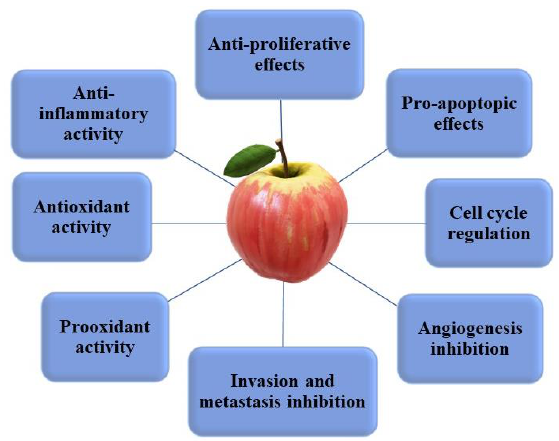
Figure 3. Main mechanisms of action of apple phytochemicals on cancer cells.